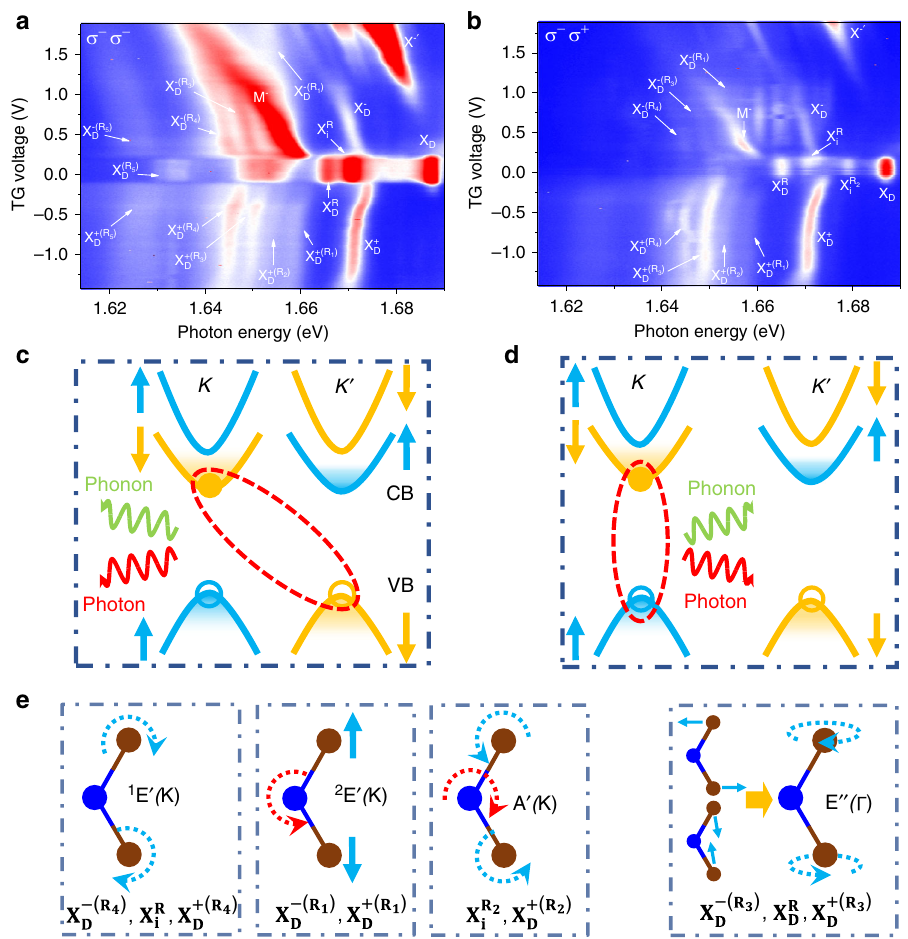
Fig. 2 Phonon replicas of the dark trions. a , b Zoom-in color plots of the PL spectra for the boxed region (red dashed line) in Fig. 1c, d, respectively. The color represents the PL intensity. c , d Schematics of light emission from the positive dark trion state through the interlayer electron – hole recombination assisted by emitting a K phonon ( c ), or through the intralayer recombination assisted by emitting a Г phonon. e Illustration of different phonon modes and associated phonon